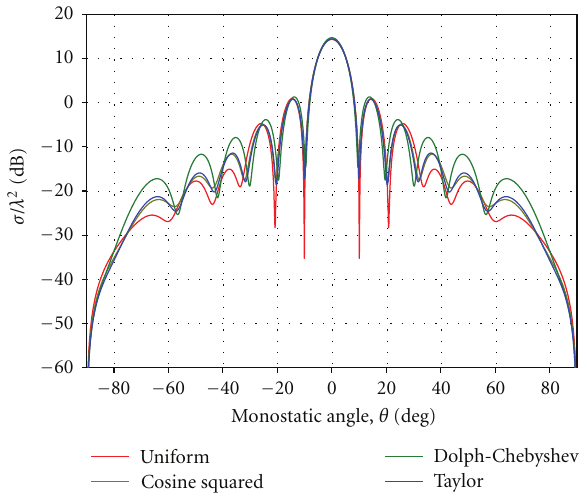
Figure 22: E ff ect of amplitude distribution on RCS of 30-element series-fed linear side-by-side dipole array including mutual cou- pling e ff ect.